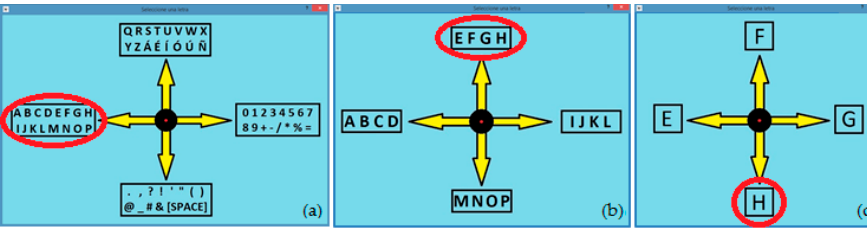
Figure 7. Selecting a character using three basic eye movements.